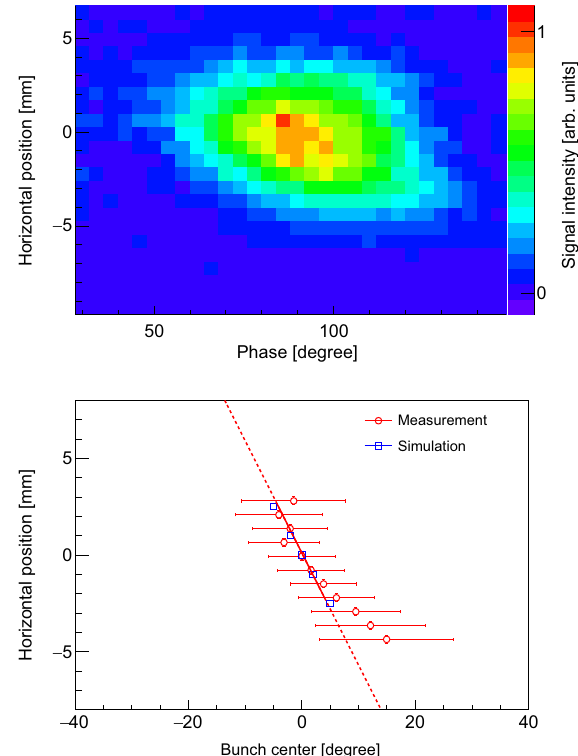
FIG. 10. Scatterplot of longitudinal phase versus horizontal target position (top) and dependence of bunch center on hori- zontal target position (bottom). The size of the HOPG target was 0 . 2 × 1 . 0 mm 2 and the lens voltage was 4.0 kV. The red-dotted line in the bottom plot indicates the fitted function. The fitting range of the bunch center is from − 4 . 5 to 4.0